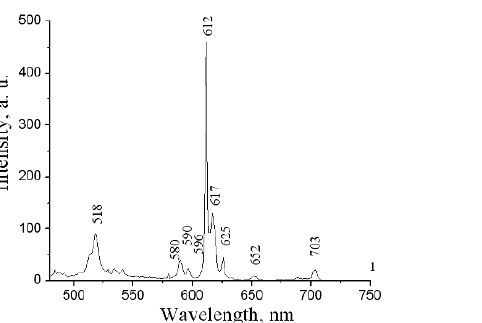
Figure 2. Emission spectra of “wet” (1) and mechanochemically (2) produced Eu(TTA)